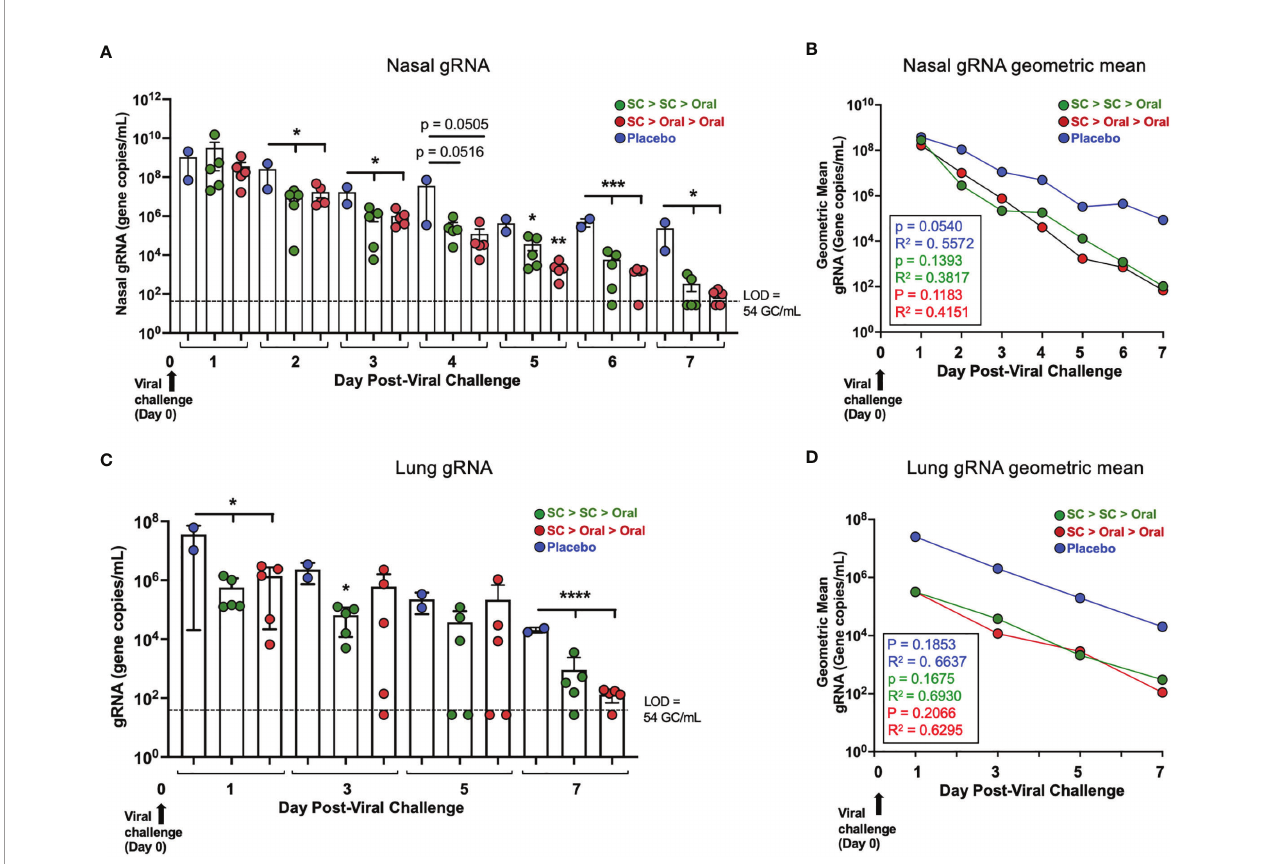
FIGURE 5 | Viral load (gRNA) in nasal passages and lung of vaccinated NHP post-challenge. (A) Individual viral gRNA and (B) the geometric mean for nasal swab samples; and (C) gRNA and (D) the geometric mean for bronchoalveolar lavage (BAL) samples. The p and R 2 values are shown in (B, D) . SARS-CoV-2 challenge was on Day 0 (Study Day 56; black arrows). The level of detection (LOD; dashed line) was 54 gene copies/mL (GC/mL) for gRNA. For values below the LOD, half the LOD value (27 GC/mL) was used for graphing of individual values and calculation of the geometric mean. Statistics performed using One-Way ANOVA with Dunnett ’ s post-hoc comparison of vaccinated groups with placebo; where *p < 0.05, **p ≤ 0.01, ***p ≤ 0.001, and ****p ≤ 0.0001. P values presented in Supplementary Table S7 . Data graphed as the mean and SEM in (A, C)